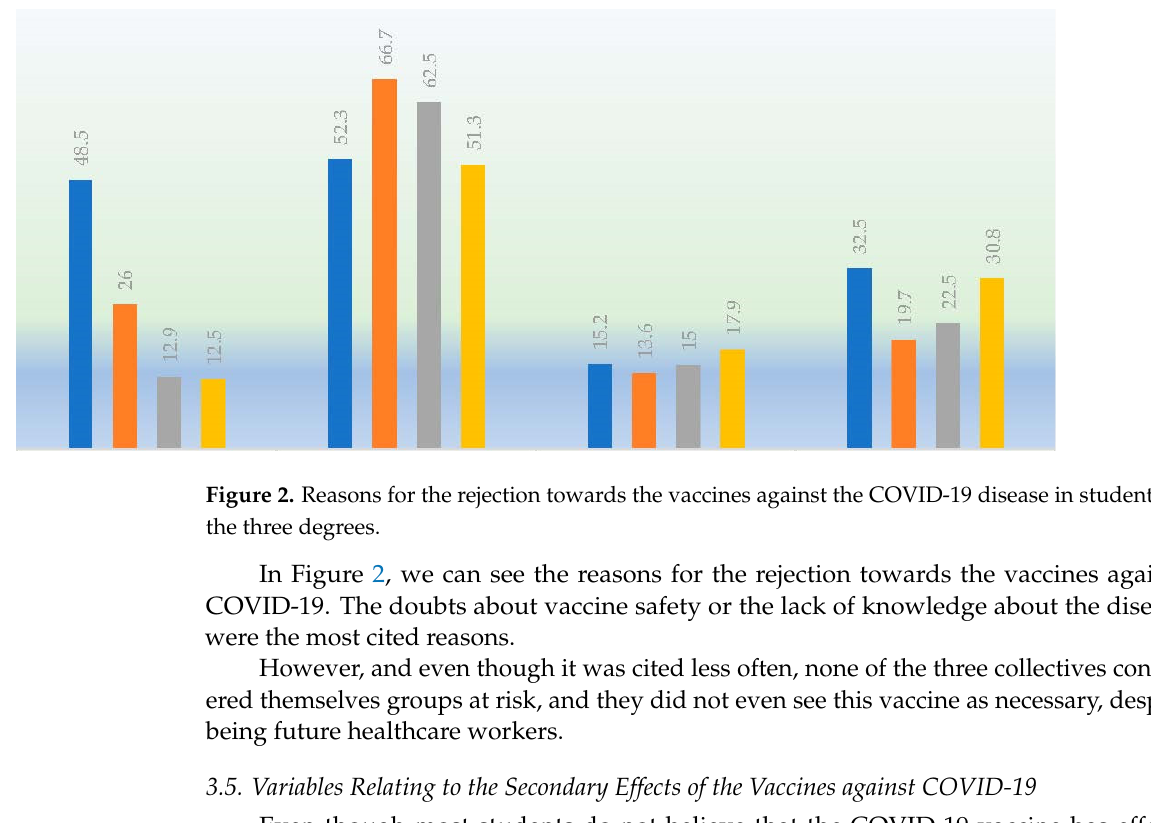
Figure 2. Reasons for the rejection towards the vaccines against the COVID-19 disease in students of the three degrees.